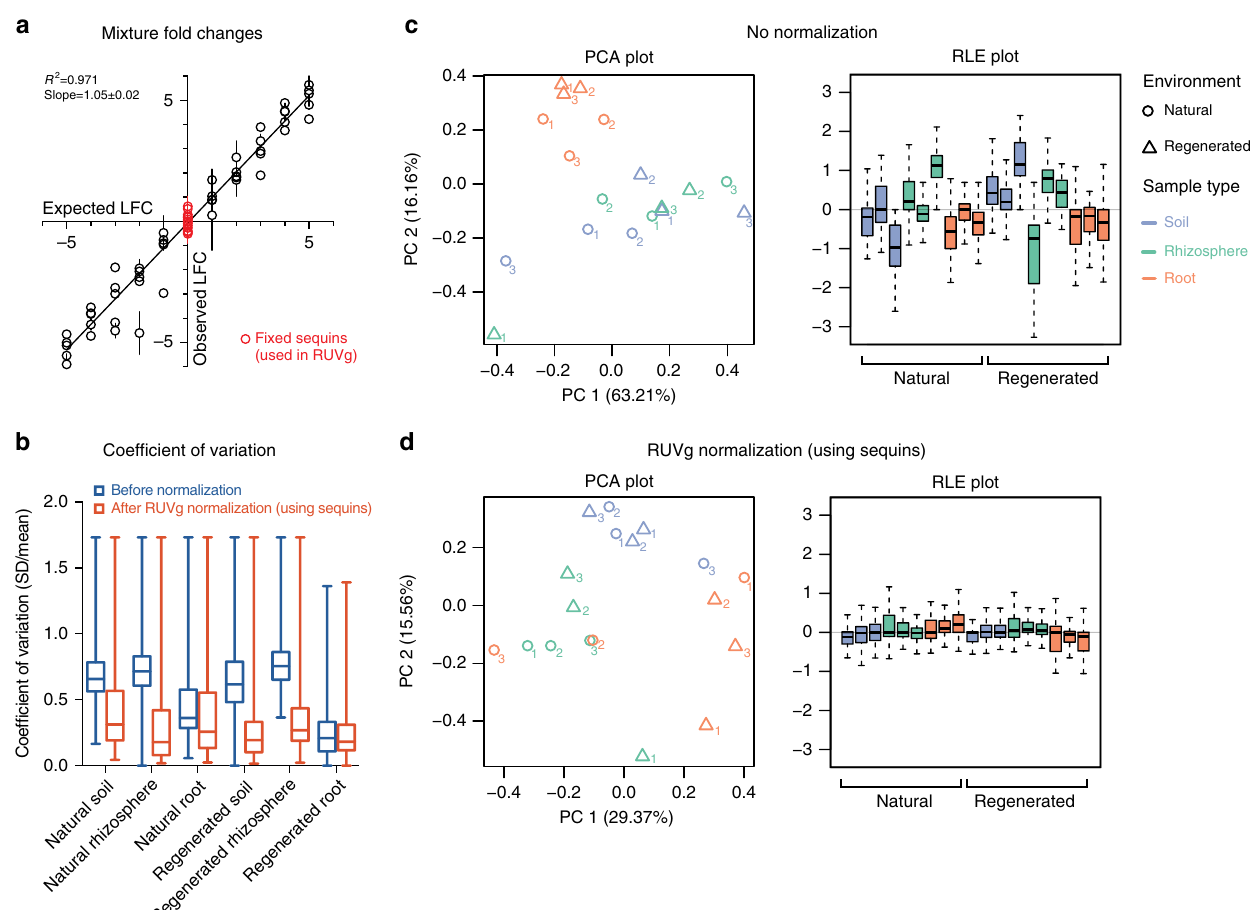
Fig. 3 Using sequins to assess fold changes and normalize between real metagenome samples of unknown content. a Scatter plot shows observed log 2 fold change (LFC) against expected LFC for each sequin across Mixes A and B (nine replicates of each). Error bars indicate standard deviation (SD) among replicates. The subset of sequins that remain fi xed between mixtures (red) are used in RUVg normalization. b Box plots show the coef fi cient of variation (SD/mean) between replicates for each phylum within each sample type, both before (blue) and after (red) RUVg normalization. Box center lines indicate median; bounds of boxes indicate upper and lower quartiles; whiskers extend to min/max values. c Without normalization, samples clustered loosely by sample type rather than environment, as shown by principal component analysis (PCA; left). However, relative log expression (RLE) box plots demonstrated a clear need for normalization, with samples not centered around zero and wide differences in variation between samples (right). d After performing RUVg normalization using sequins, samples still clustered by sample type (left), and RLE plots showed a marked improvement with samples now centered around zero and the excessive variation of most samples removed (right). Quanti fi cation results are based on phylum-level abundance estimates from read mapping (using MG-RAST; n = 75